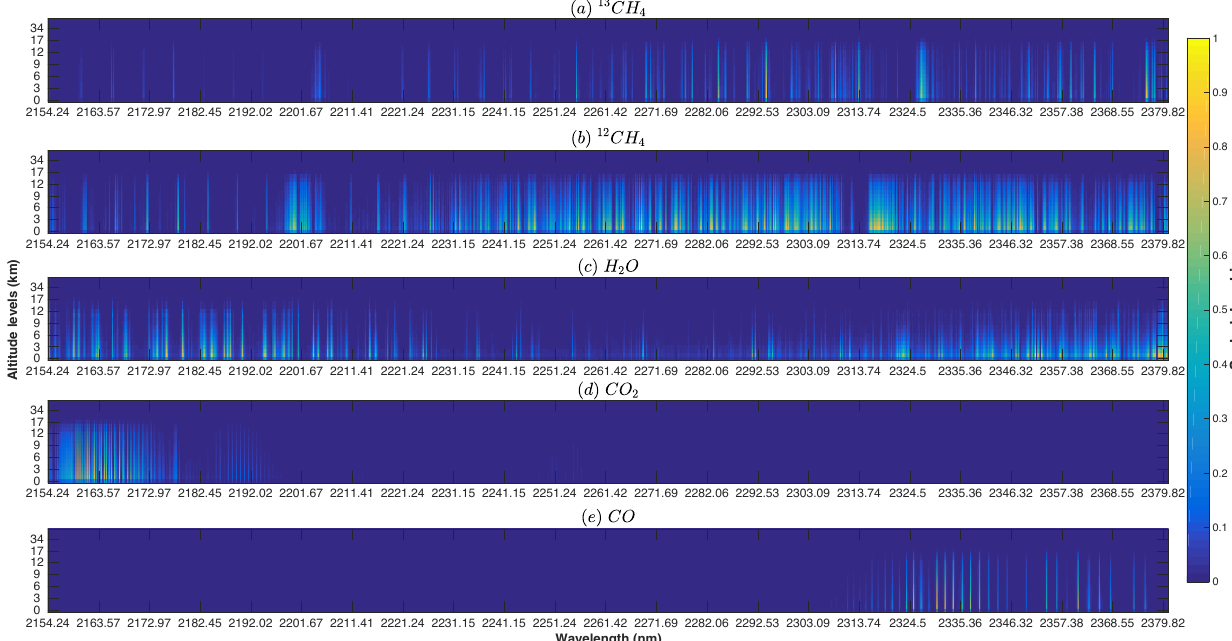
Figure 4. Normalised sensitivity (between 0 and 1) of GOSAT-2 measured radiance with respect to a variation of 1% of the concentration of the main constituent gases in the 2154–2380nm (band 3) wavelength range; 13 CH 4 (a) , 12 CH 4 (b) , H 2 O (c) , CO 2 (d) and CO (e) . All calculations were performed using the ORFM RTM, assuming a solar zenith angle of 30 ◦ , a viewing zenith angle of 0 ◦ and a surface albedo of 0.1, in conjunction with the HITRAN2012 database and the University of Leicester model MIPAS atmosphere. Table 3. Description of scenarios undertaken to determine potential 13 CH 4 content in GOSAT-2/TANSO-FTS-2.